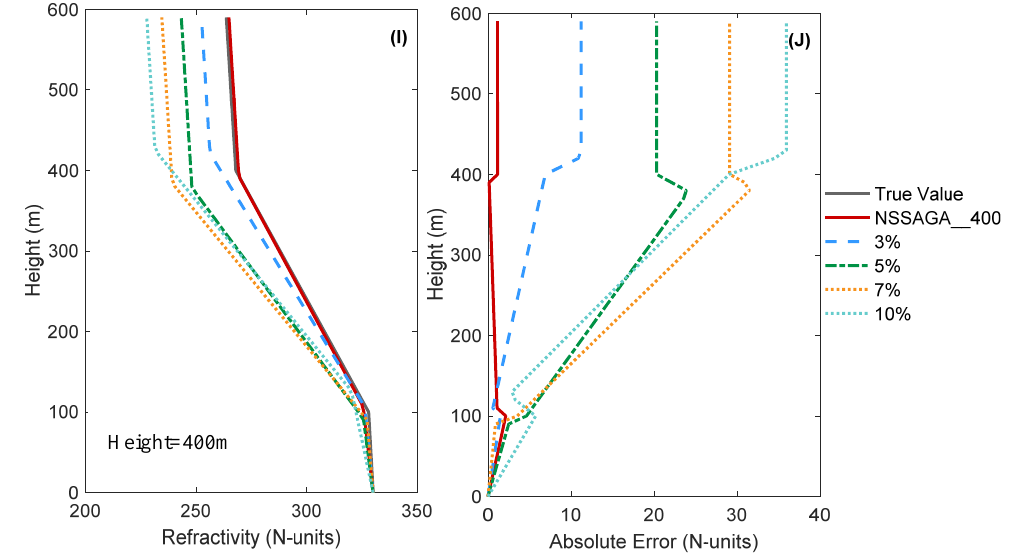
Figure 6. The retrieved refractivity profile and corresponding absolute error by NSSAGA under different Gaussian Noise levels. Antenna heights used are ( a , b ) 20 m; ( c , d ) 50 m; ( e , f ) 100 m; ( g , h ) 150 m; ( i , j ) 400 m. Table 2. The value of inversion parameters under different antenna heights and Gaussian noise levels (bold font indicates best retrieved parameters).